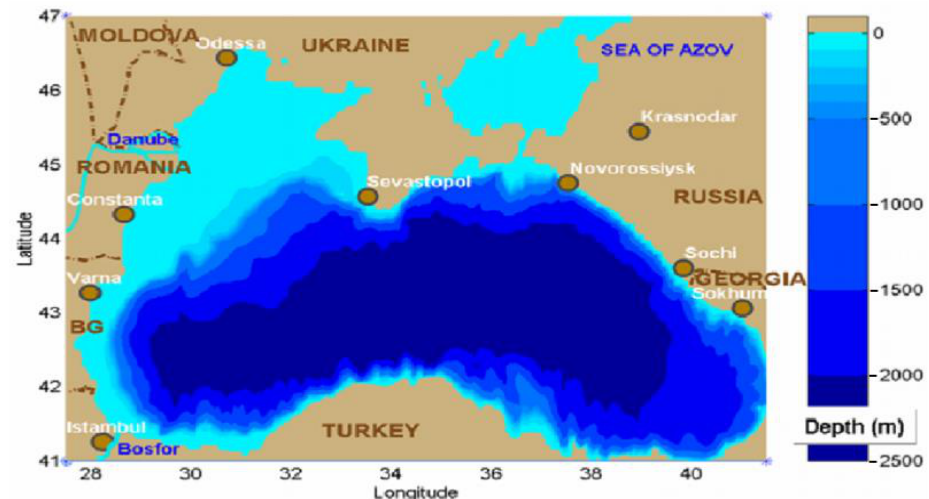
Figure 1. The bathymetric chart of the Black Sea. [23]